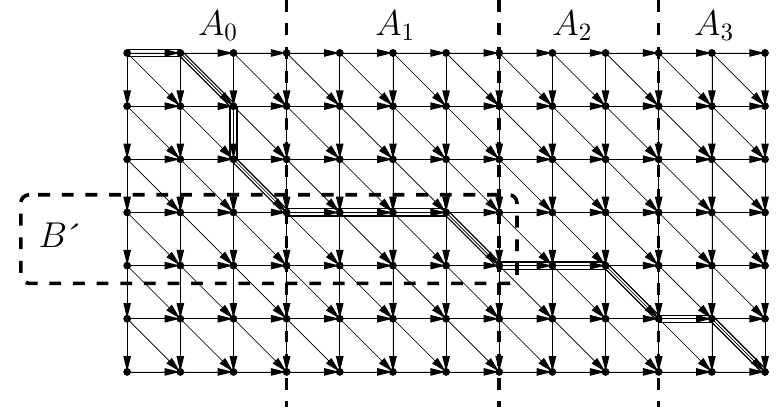
Figure 4. A schematic edit distance graph between A and B . The dashed lines show the division of A and B into the A ’s and delimit B (cid:48) . The shortest path in the graph is enclosed i between two parallel